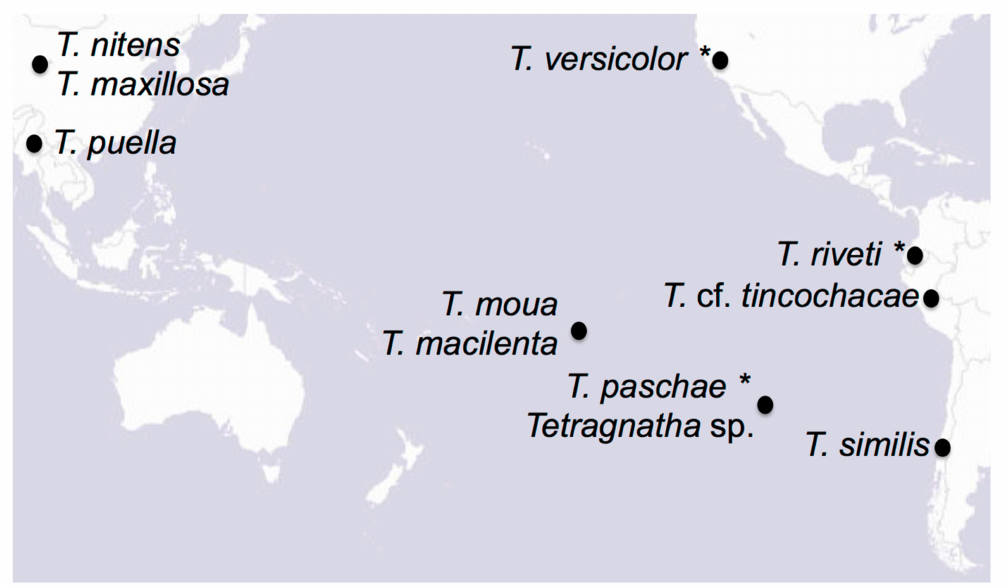
Figure 1. Map of the Pacific Rim with the species included on this study. Names with asterisks correspond to museum specimens. Map from